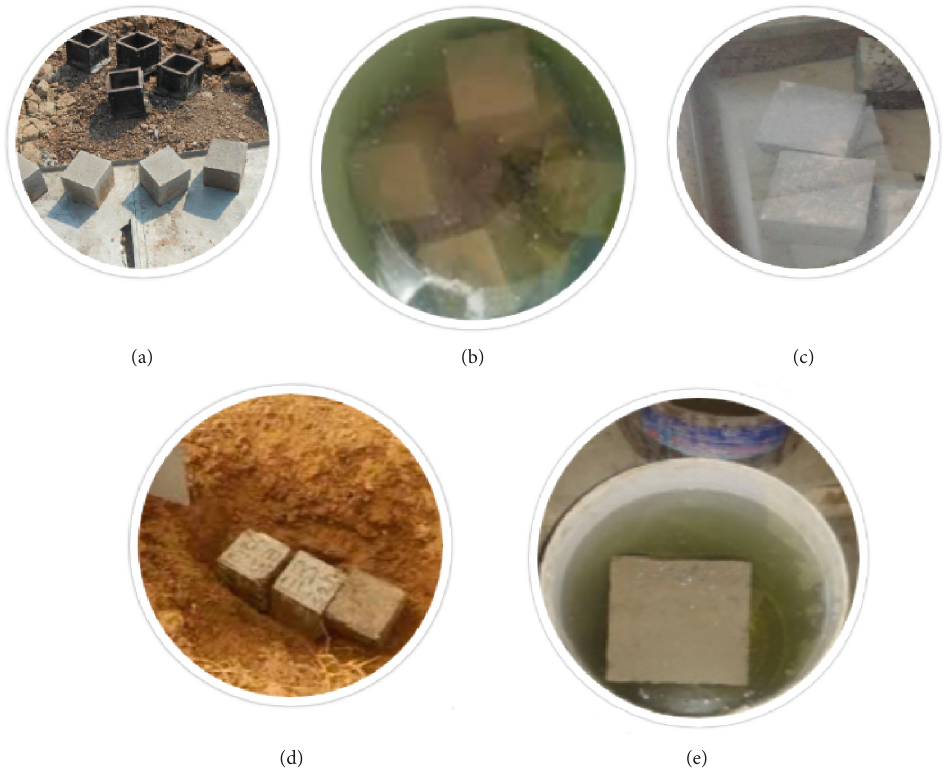
Figure 2: (a) Mild. (b) Moderate. (c) Severe. (d) Very severe. (e) Extreme